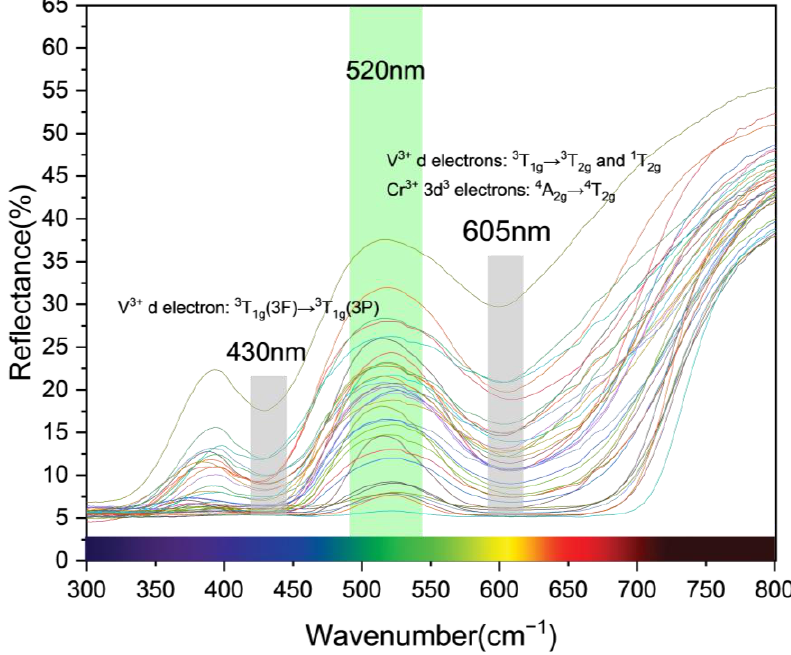
Figure 6. UV-VIS spectrum of 35 tsavorites (520 nm is the transmission window).